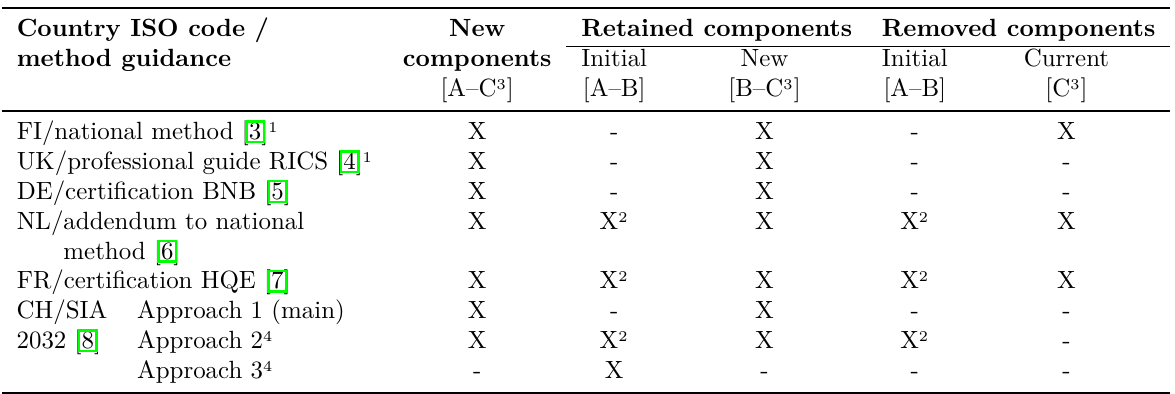
Table 1. Overview of selected